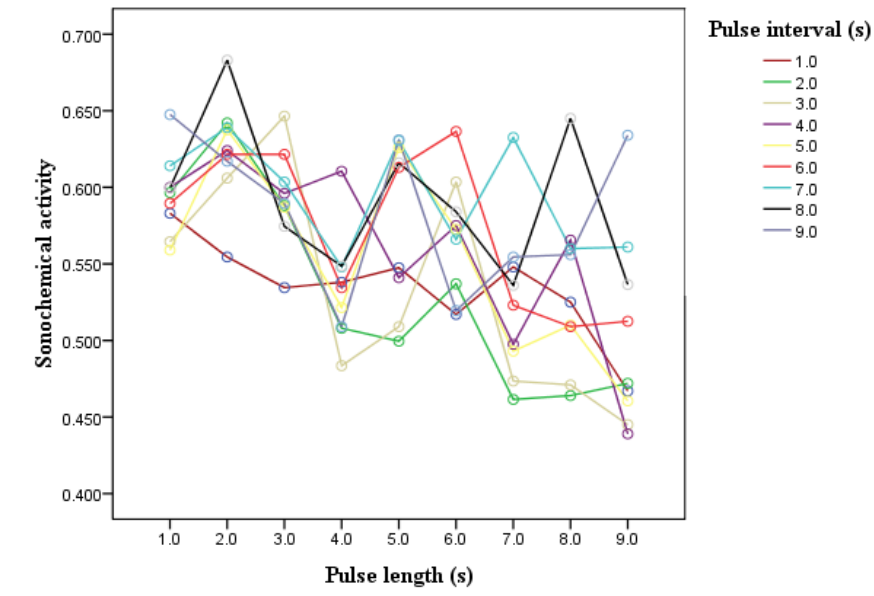
Figure 3. Interaction between pulse length (1–9 s) and pulse interval (1–9 s).